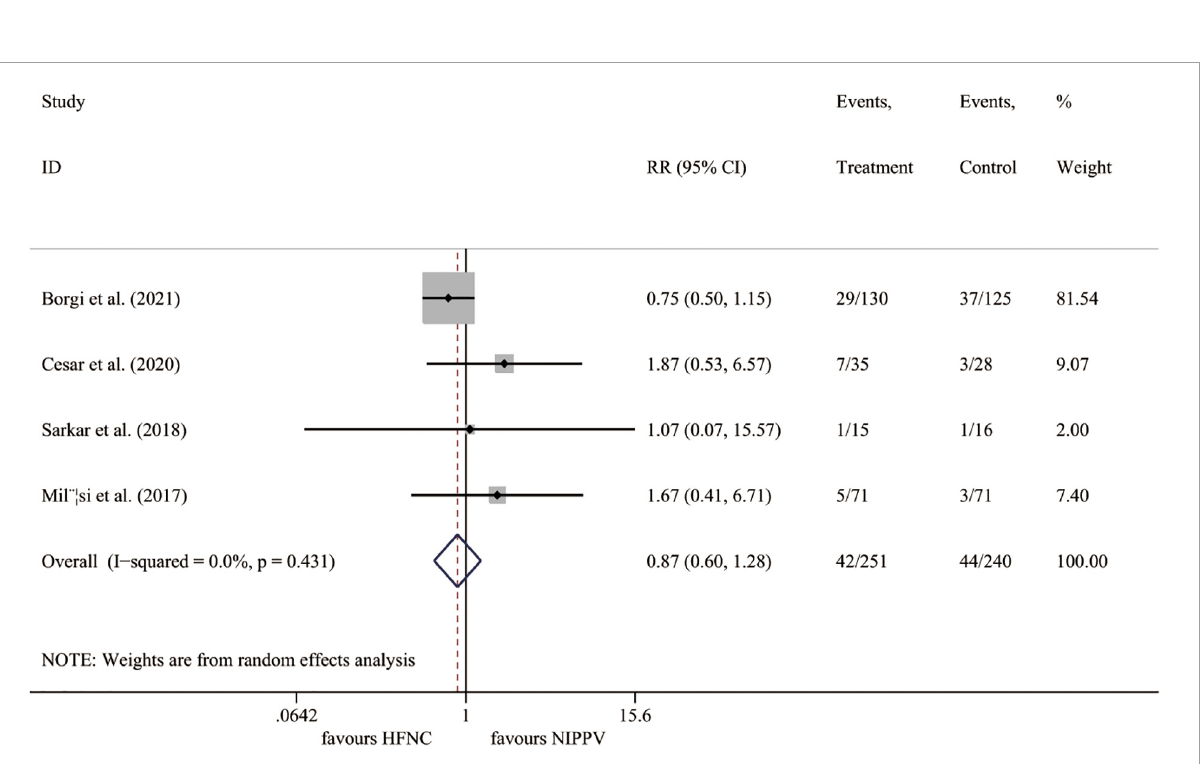
FIGURE4 Forest plot for intubation rate. RR, relative risk; HFNC, high flow nasal cannula; NIPPV, non-invasive positive pressure